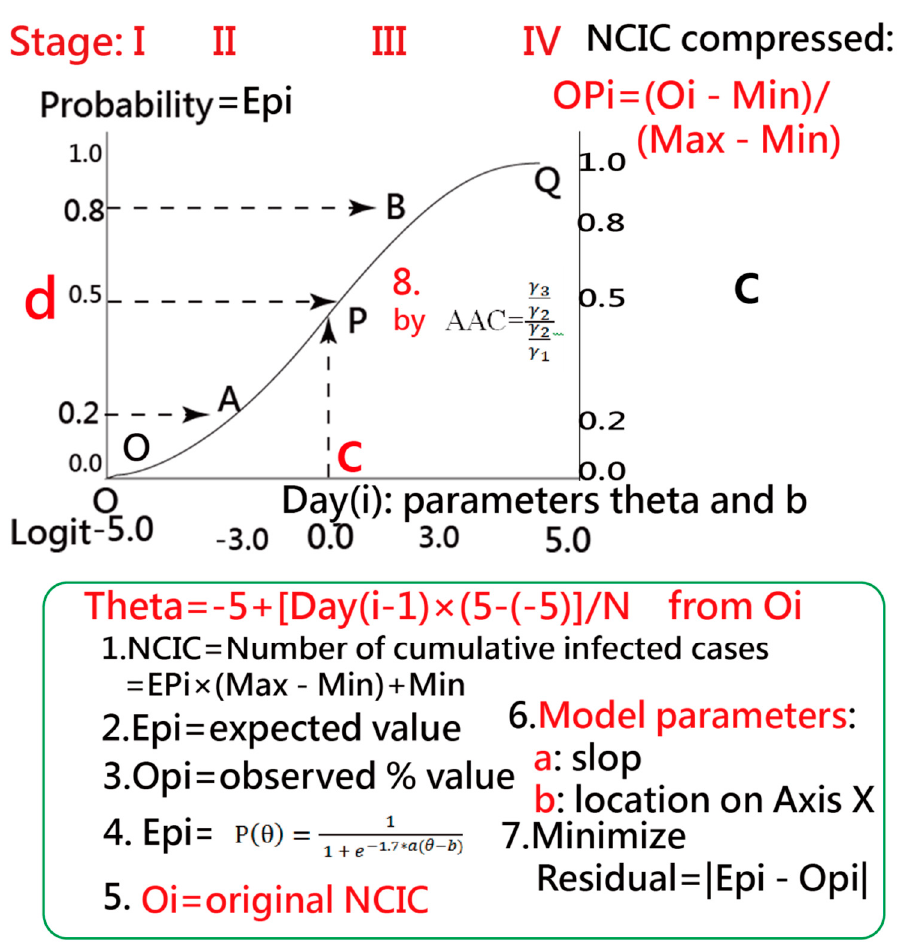
Figure 1. Determining the Inflection Point (IP) on an ogive curve and the ipcase-index denoted by the four-point OcPd rectangle using the Item Response Theory model.